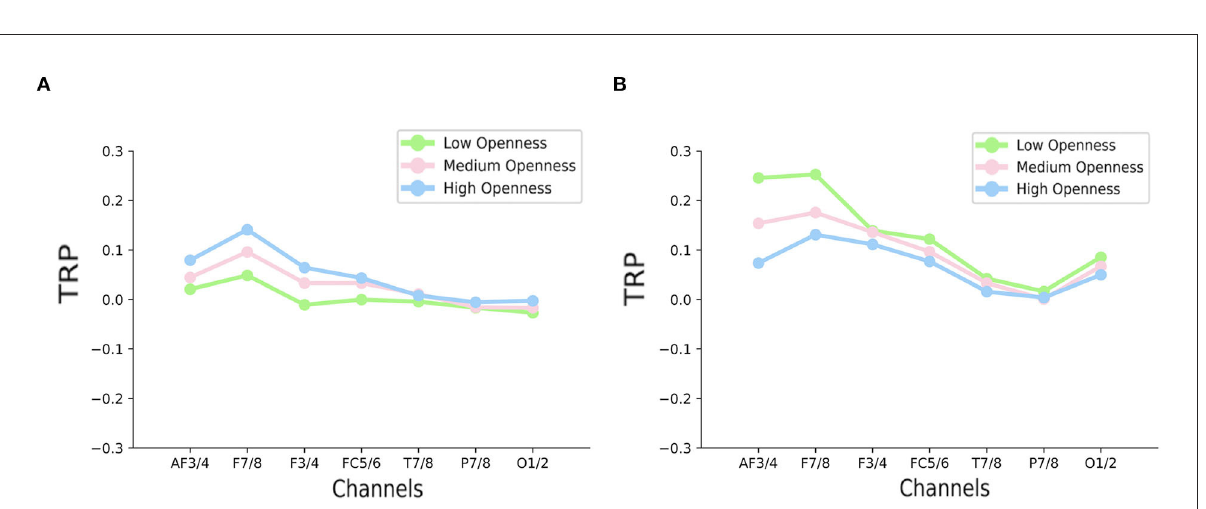
FIGURE5 Task-related power (TRP) changes in the upper alpha band over seven channel pairs, (A) in RAPM, (B) in LSAT, according to the openness level—low, medium, and high openness corresponding, respectively, to green, pink, and blue dots.